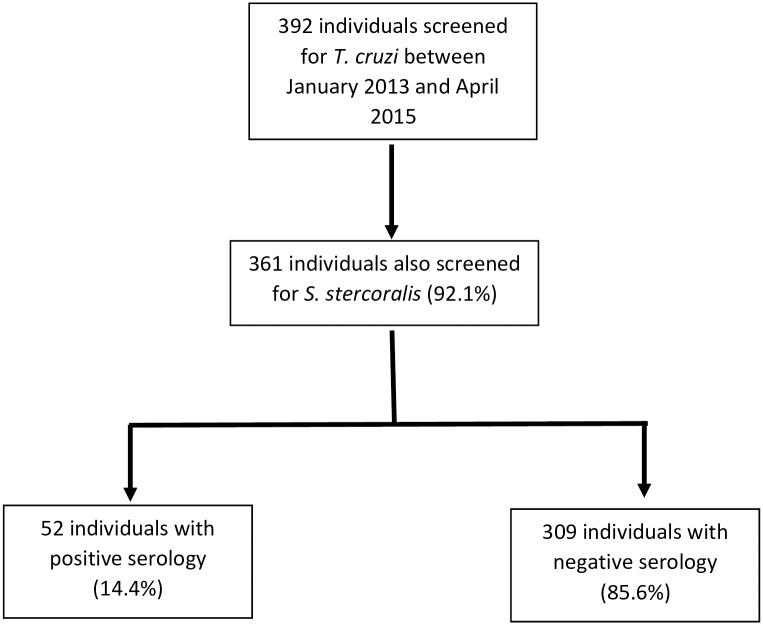
[Flowchart] Flowchart of individuals screened for S. stercoralis and finally included in the study.